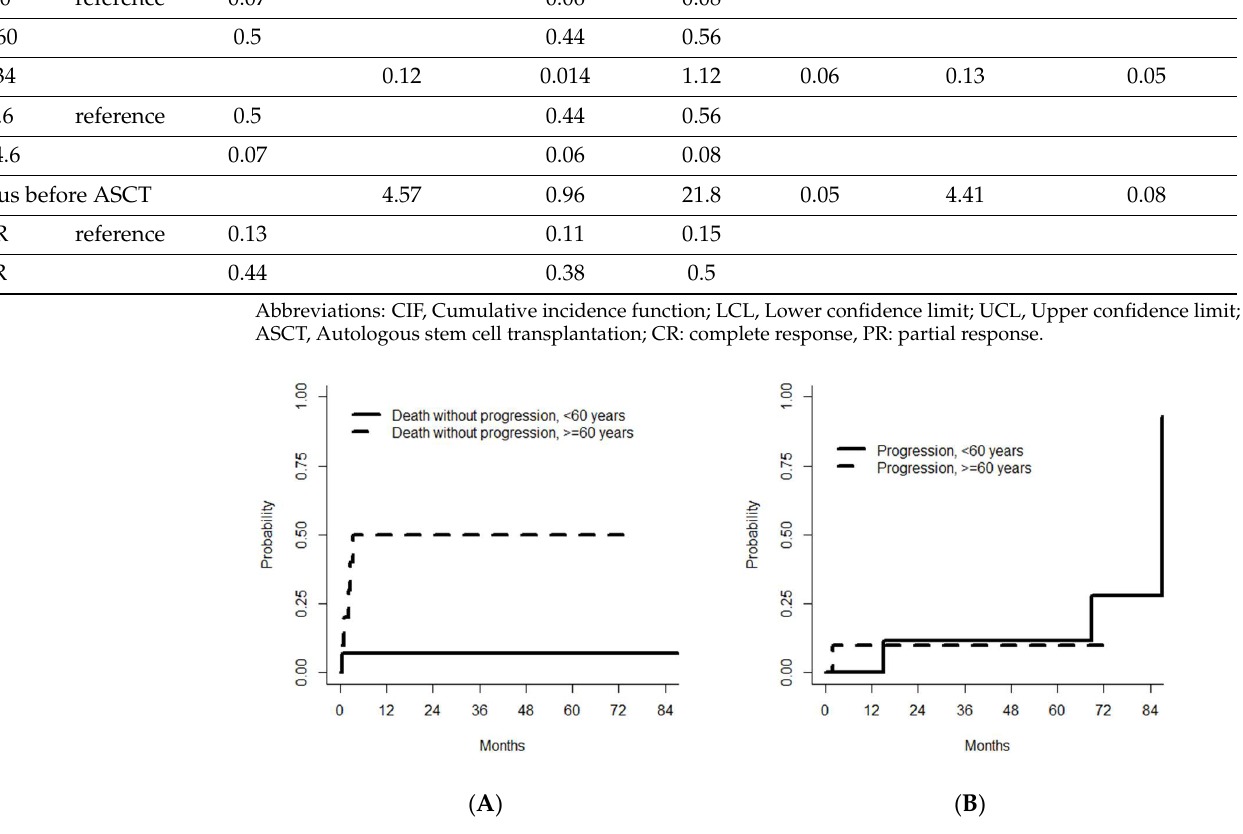
Figure 3. Cumulative incidence of death without progression (i.e., TRM) ( A ) and disease progression ( B ), by age. Table 3. Competing risks analysis.